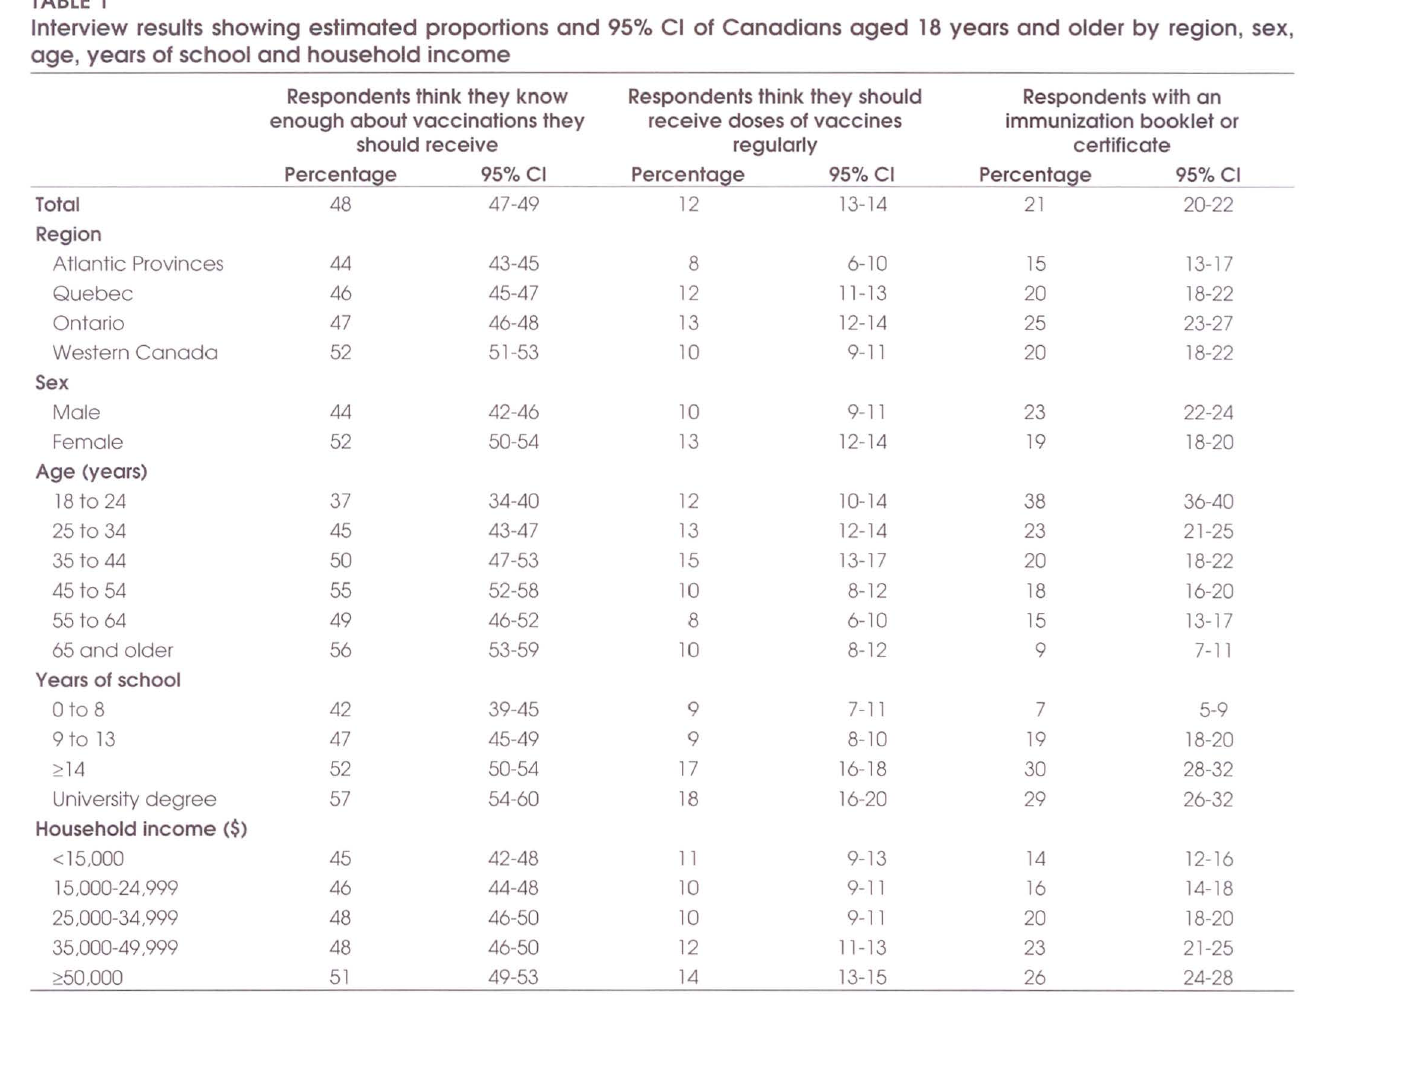
Interview results showing estimated proportions and 95% Cl of Canadians aged 18 years and older by region, sex, age, years of school and household